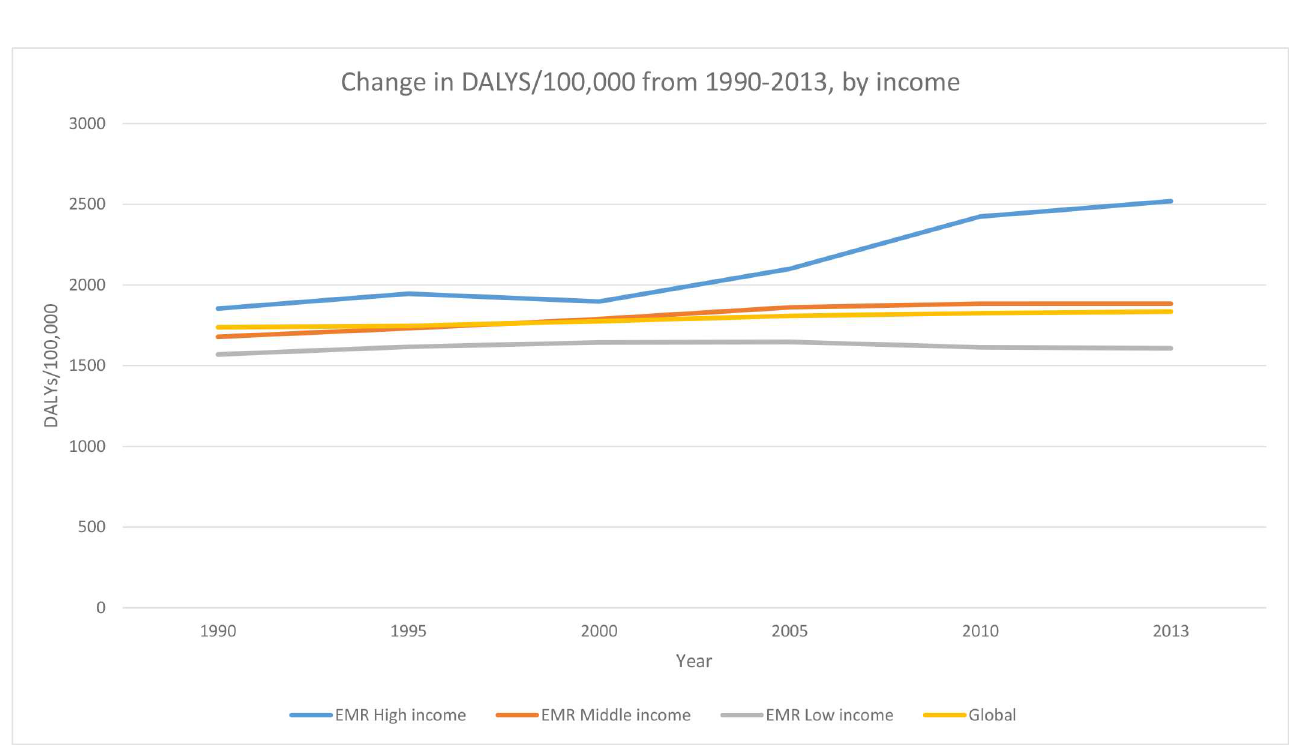
Fig 5. Change in DALYS/100,000 from 1990–2013, by income.